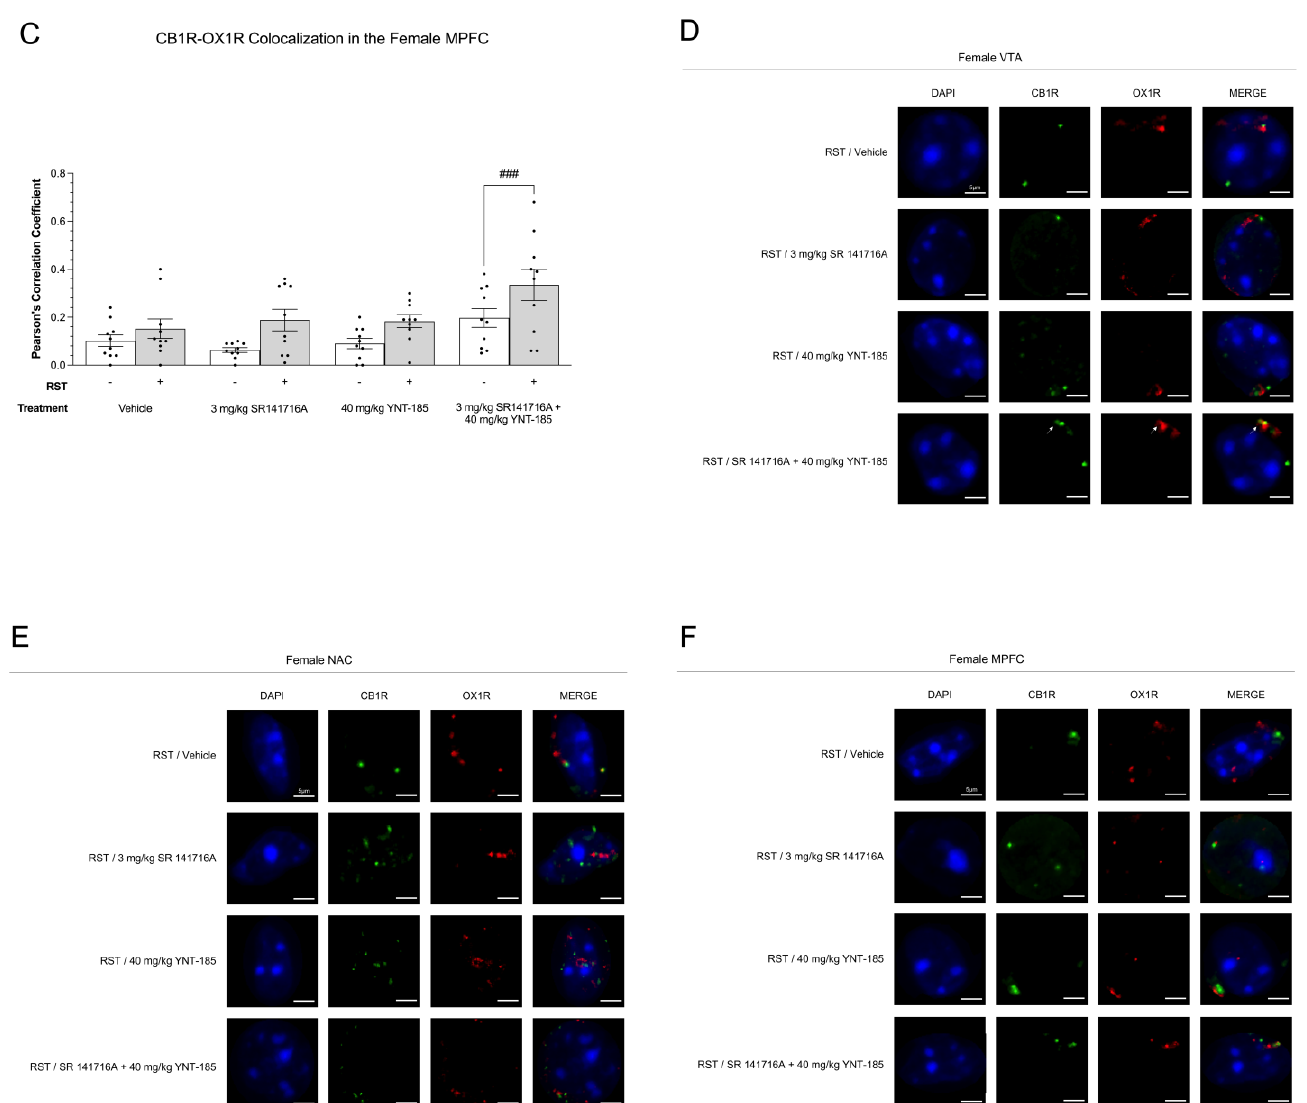
Figure 7. Colocalization of CB1R and OX1R in female mesocorticolimbic brain regions as a result of prolonged restraint stress and drug treatments. ( A – C ), CB1R-OX1R colocalization in the VTA ( A , D ), NAC ( B , E ), and MPFC ( C , F ) of 200 µL vehicle, 3 mg/kg SR141716A, 40 mg/kg YNT-185, and 3 mg/kg SR141716A + 40 mg/kg YNT-185-treated adult female C57BL/6 mice. On day 8, following the final sucrose preference measurement, mice were anesthetized and perfused in order to collect brain tissue for immunohistochemical analysis. Colocalization images were taken using a Zeiss LSM880 confocal microscope. Images were then analyzed on the FIJI extension of ImageJ (version 2.1.0).